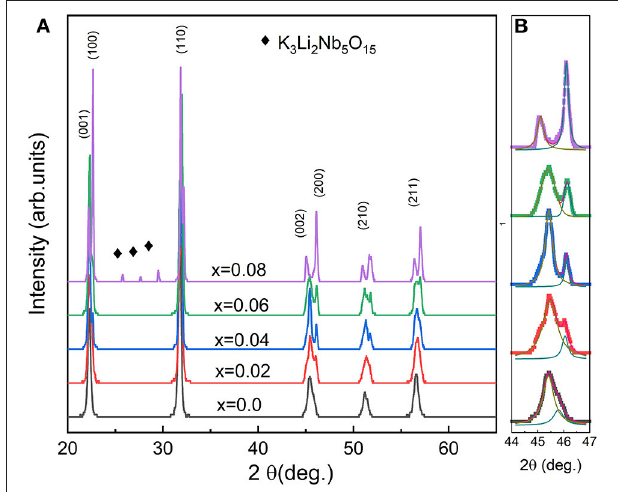
FIGURE 2 | SEM images of (1- x )KNBNNO- x LiNbO 3 ceramics for (A) x = 0.00, (B) x = 0.02, (C) x = 0.06, and (D) x = 0.08.